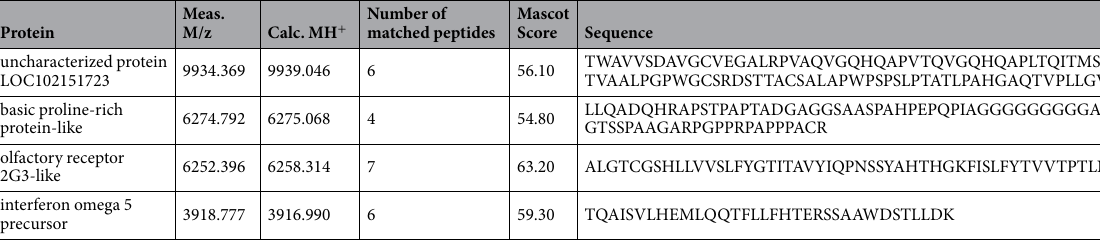
Table 3. The identification of the potential markers used for the estimation of PMI in rat liver tissues.